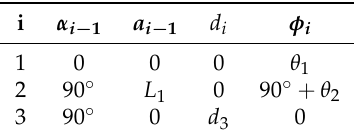
Table 1. DH parameters of P 1